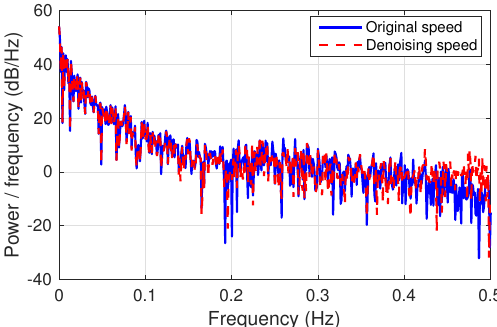
Figure 3. The power spectral density of vehicle speed.